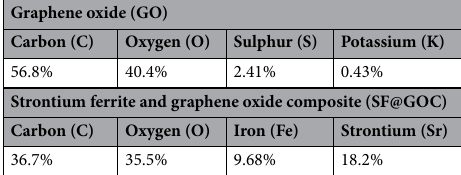
Table 1. Elemental analysis from